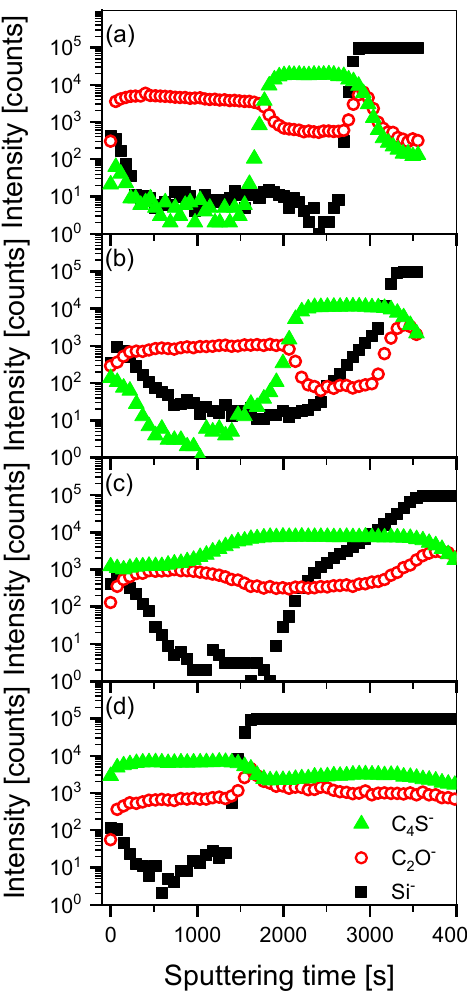
Figure 3. SIMS depth profiles of PC 60 BM/P3HT bilayers: ( a ) as-prepared or exposed to chloroform vapor for ( b ) 30 min, ( c ) 45 min and ( d ) 60 min.